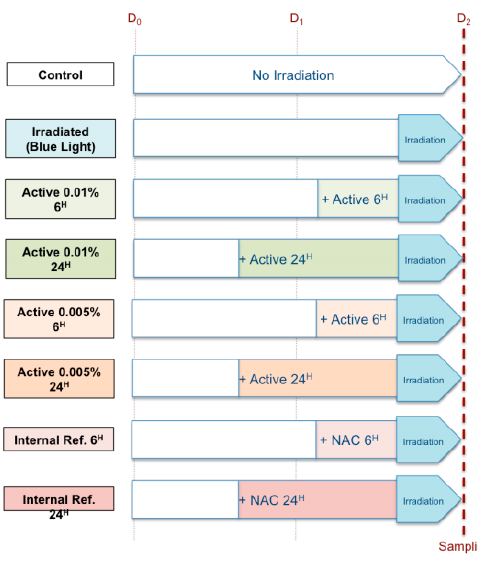
Figure 1. Experimental design. Table 1. Main characteristics of blue light